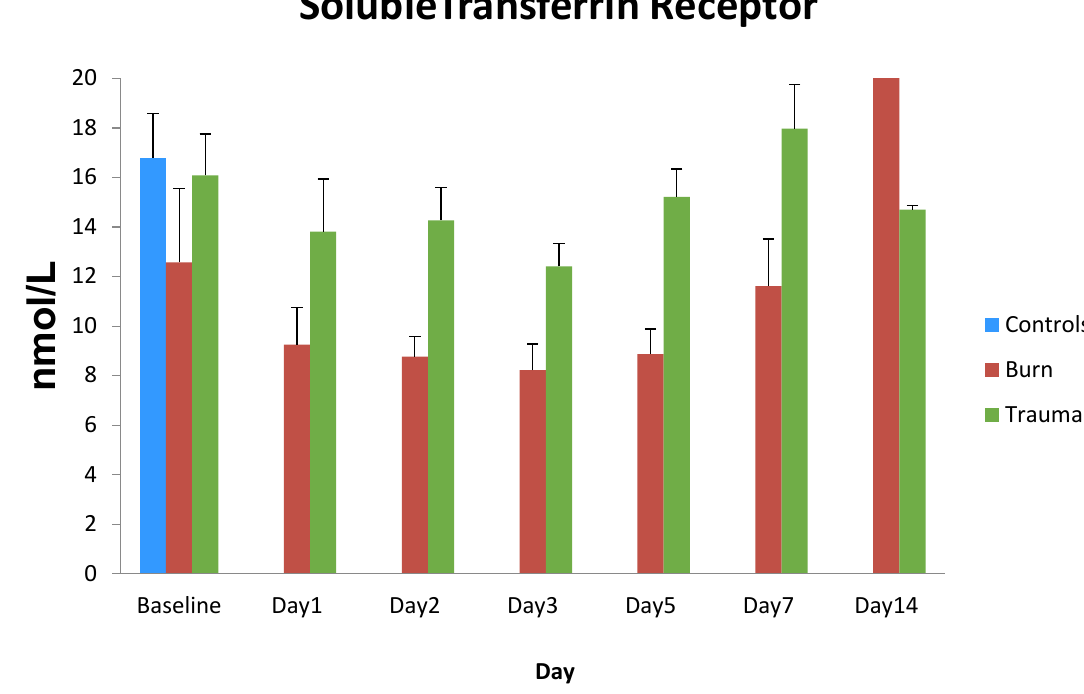
Figure 6. Soluble transferrin receptor levels in plasma from thermally injured and non-burned trauma patients. Data expressed as mean ± SE from 24 burned and 35 non-burned trauma patients and 10 healthy